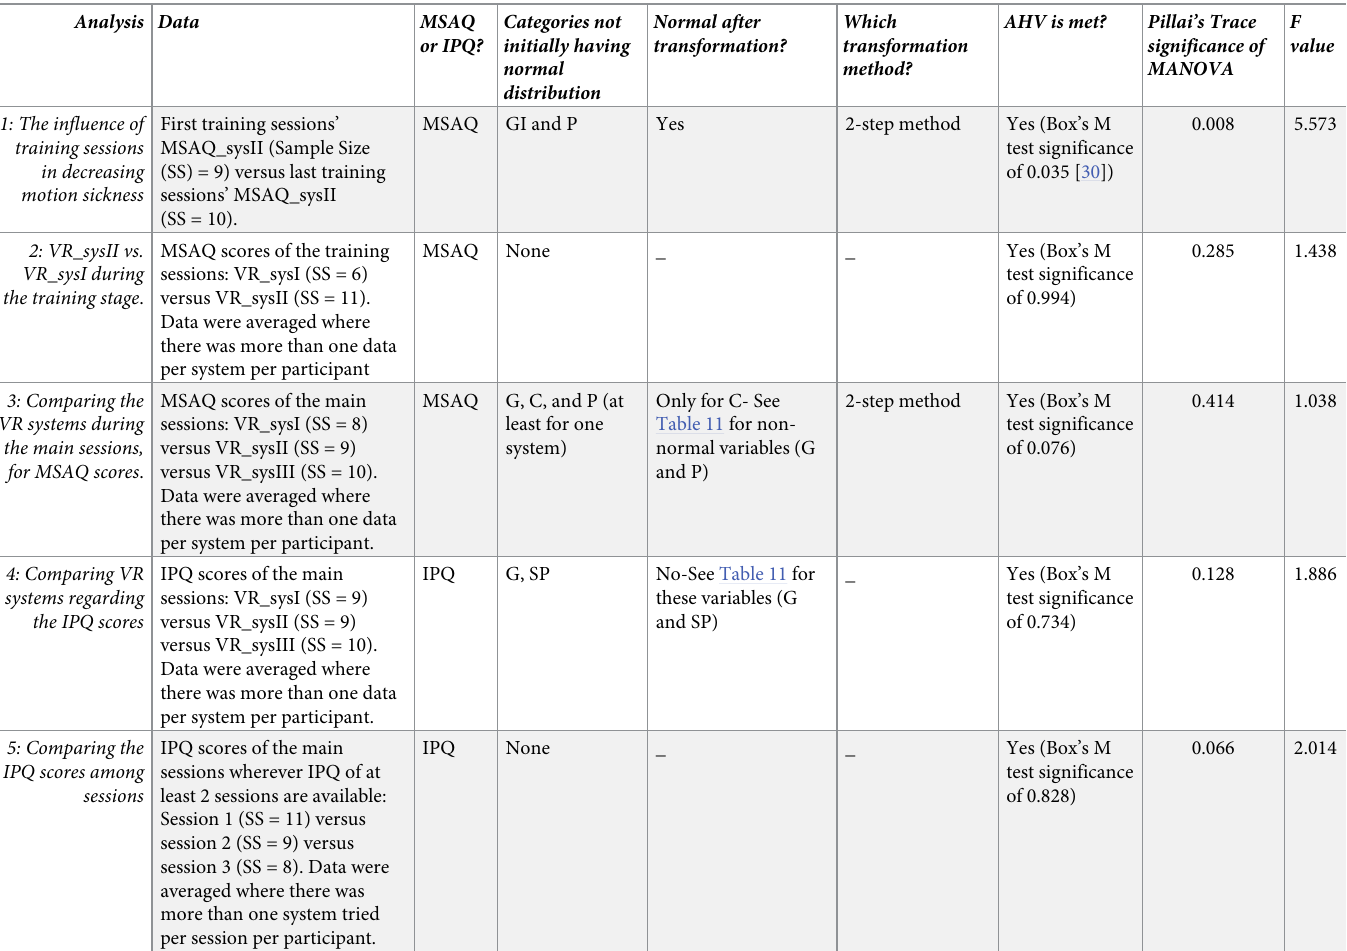
Table 4. Details of statistical procedures for the analyses 1 to 5.